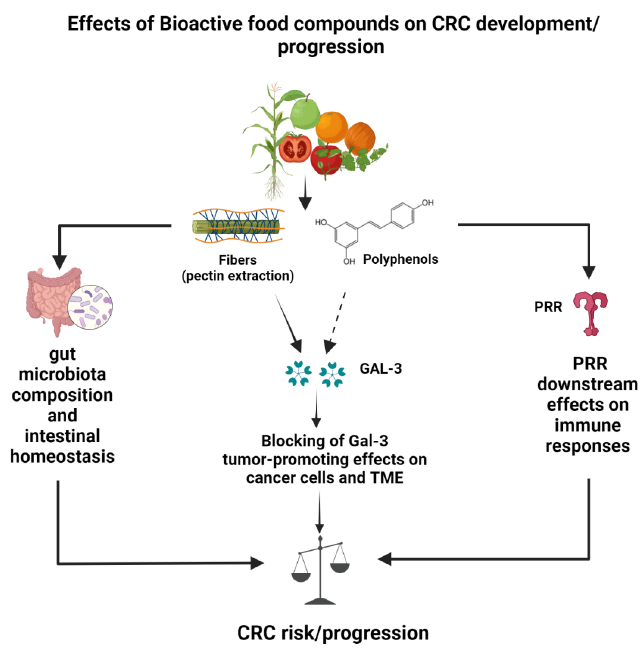
Figure 3. Schematic model of galectin-3-dependent and -independent effects of dietary fibers and polyphenols potentially leading to reduced CRC risk and progression. Galectin-3-independent protective effects occur through modulation of gut microbiota and attenuation of inflammatory responses induced by pattern recognition receptor (PRR) triggering in immune cells. Galectin-3-dependent protective effects on CRC have been demonstrated for pectin (full arrow) and, so far, only suggested for polyphenols (dotted arrow). Furthermore, as the effects of these molecules can vary widely according to their structure, administration route and in vivo bioavailability, additional structural composi- tion studies are recommended. Likewise, more attention needs to be paid to still unclear aspects accounting for their systemic and tumor bioavailability following food consump- tion. Consequently, the recommendations for their intake are expected to change from a